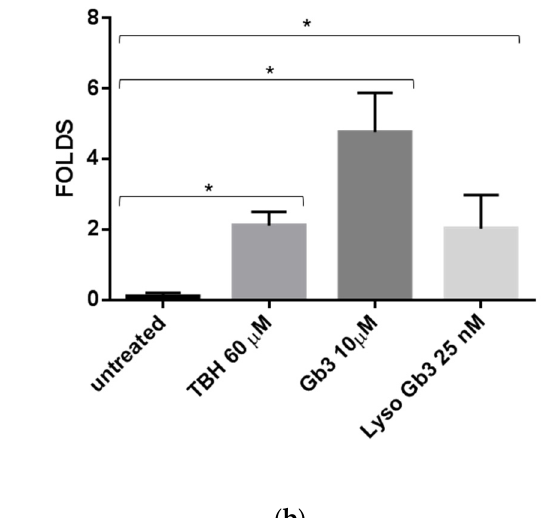
Figure 9. Variation in miR-126a-3p levels in HUVEC treated with TBH 60 µM, Lyso-Gb3 25 nM, and Gb3 10 µM. Bar charts show intracellular ( a ) and sEVs miR-126-3p levels ( b ). Data were calculated by qRT-PCR and represent mean ± SD of three different experiments analyzed in triplicate. CTs (cycle thresholds) resulting from qRT-PCR analysis were normalized with miR-30a (EVs) and RNU6b (intracellular); miR-126a-3p levels were calculated with 2- Δ CT method and expressed as folds, with respect to lowest value registered. Comparison among multiple groups was analyzed by one-way analysis of variance, followed by Bonferroni’s post hoc test. * p < 0.01 .